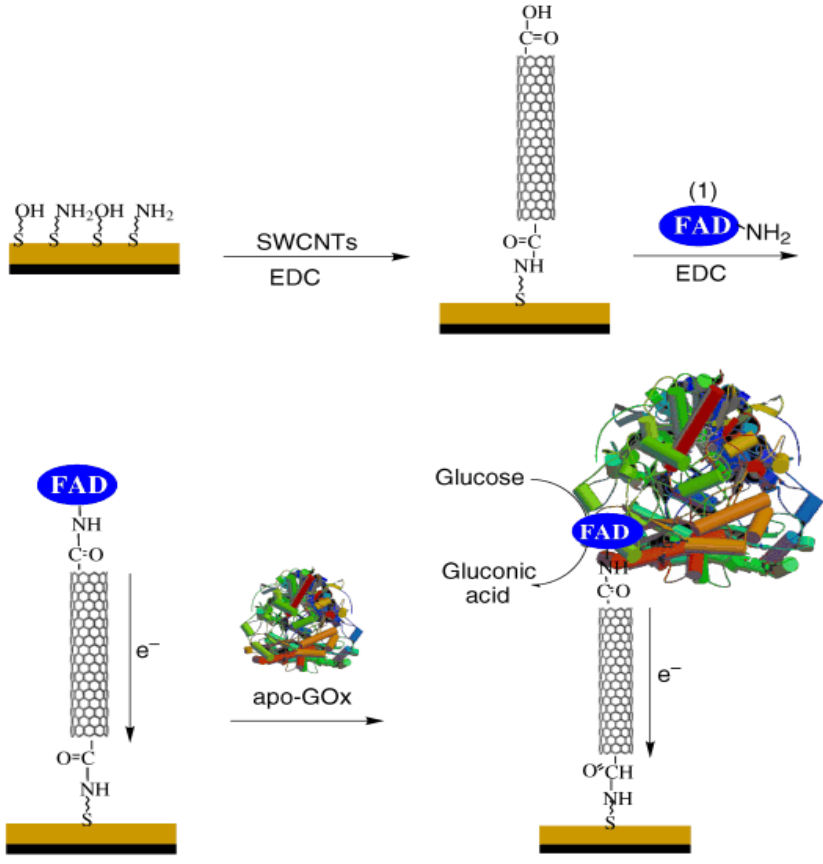
Figure 1. Assembly of the SWCNT electrically contacted glucose oxidase electrode. A 2-thioethanol/ cystamine mixed monolayer (3:1 ratio) was assembled on an Au electrode and the length fractionalized SWCNTs were coupled to the surface in the presence of the coupling reagent 1-ethyl-3-(3-dimethylaminopropyl) carbodiimide hydrochloride (EDC). The amino derivative of the FAD cofactor (1), was then coupled to the carboxy groups at the free edges of the standing SWCNTs. Finally, Apo-glucose oxidase, apo-GOx, was then reconstituted on the FAD units linked to the ends of the standing SWCNTs. Reprinted with permission from